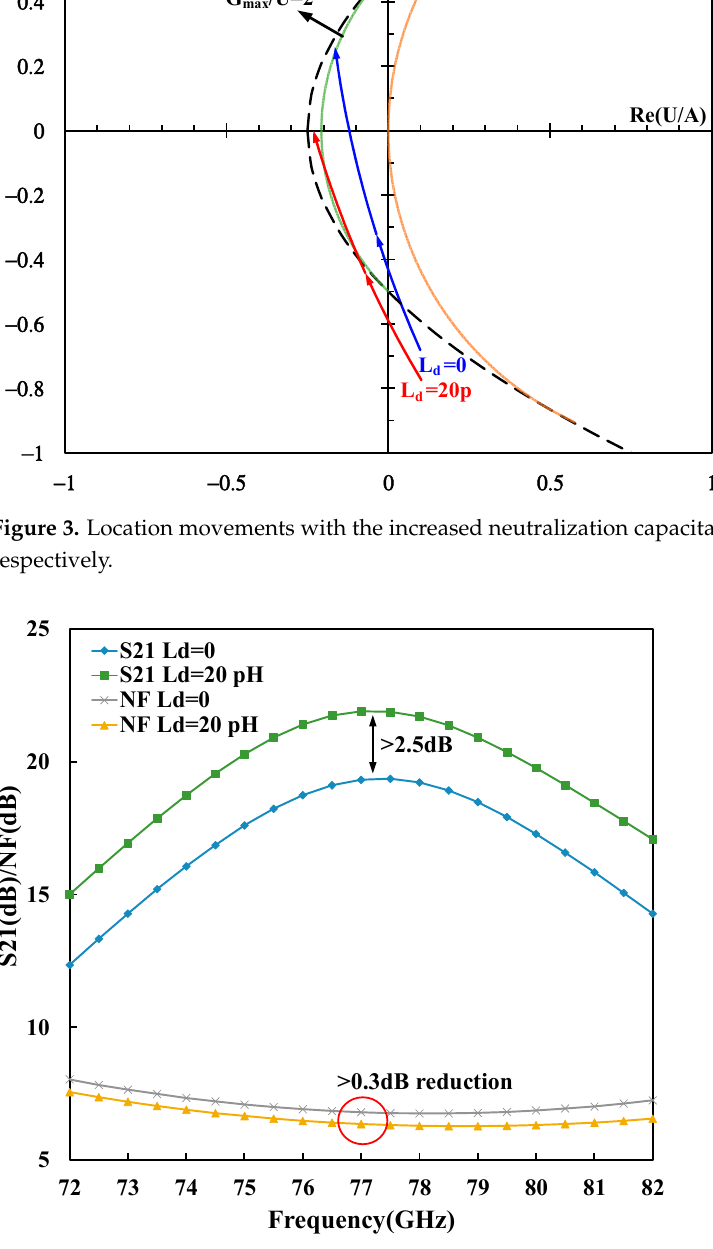
Figure 4. Simulated S21 and NF with and without L d , respectively.